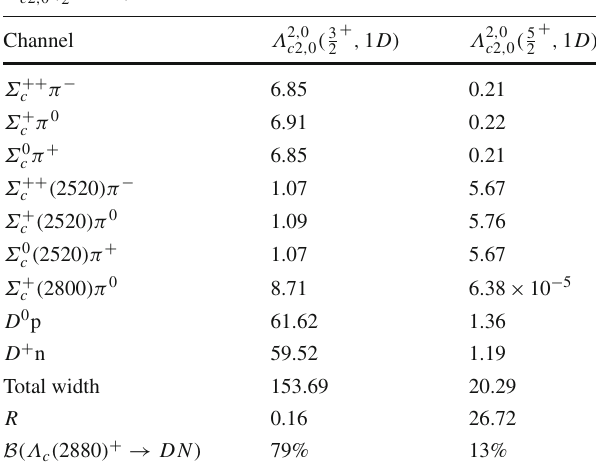
Table 5 Possible decay widths (MeV), branching fraction of